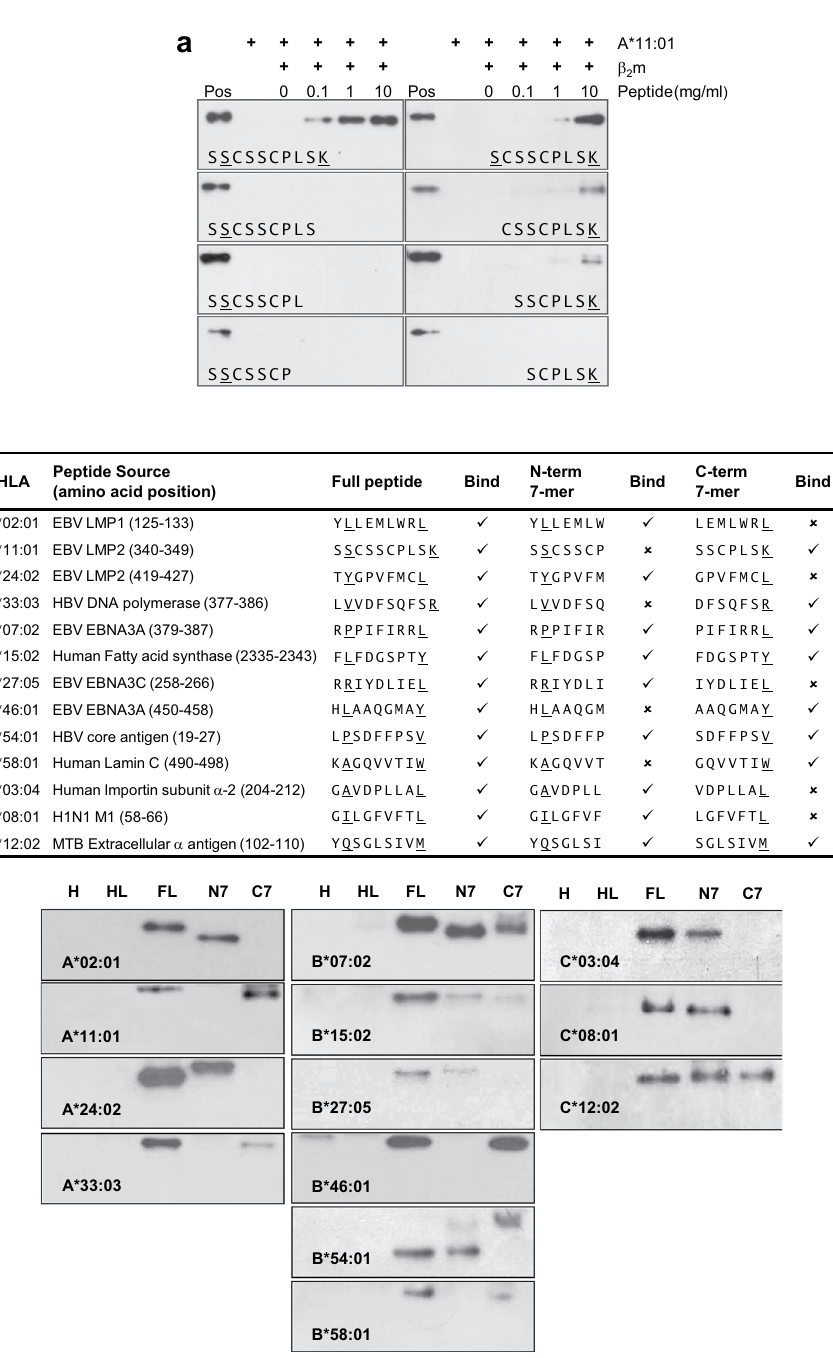
Figure 3. Stabilization of pHLA complexes by single non-canonical short peptides. ( a ) Stabilization of pHLA complexes formed by HLA-A * 11:01 heavy chain and β 2 m with HLA-A * 11-restricted SSCSSCPLSK or its C-terminal truncated peptides (SCSSCPLSK, CSSCPLSK and SSCPLSK) in a dose-dependent manner (0, 0.1, 1 and 10 mg/ ml) as determined by native western blot with W6/32 antibody. pHLA complex of HLA-A * 11:01 heavy chain and β 2 m refolded with 10 mg/ml of full-length SSCSSCPLSK peptide served as the positive control (Pos). HLA-A * 11:01 heavy chain and HLA-A * 11:01 heavy chain with β 2 m served as the negative controls. ( b ) Tabulation of MHC class I molecules refolding in-vitro with N-terminal (N-term) 7mer peptide (P2 anchor underlined) and/or C-terminal (C-term) 7mer peptide (PΩ anchor underlined) as determined by native western blot with W6/32 antibody shown in the lower panels. Presence of bands detected by W6/32 antibody in the native western blot indicates the presence of stabilized pHLA complexes. Due to the difference in overall charge-to-mass ratio of the different pHLA complexes formed by different peptides and peptide lengths, a variation in the migration rates of the different pHLA complexes in the native PAGE gels can be observed. For each indicated HLA allele, heavy chain (H), heavy and β 2 m light chain (HL) served as the negative controls while pHLA complex with full peptide (FL) served as the positive control for each western blot panel. EBV, Epstein-Barr Virus; HBV, Hepatitis B Virus; MTB, Mycobacterium tuberculosis